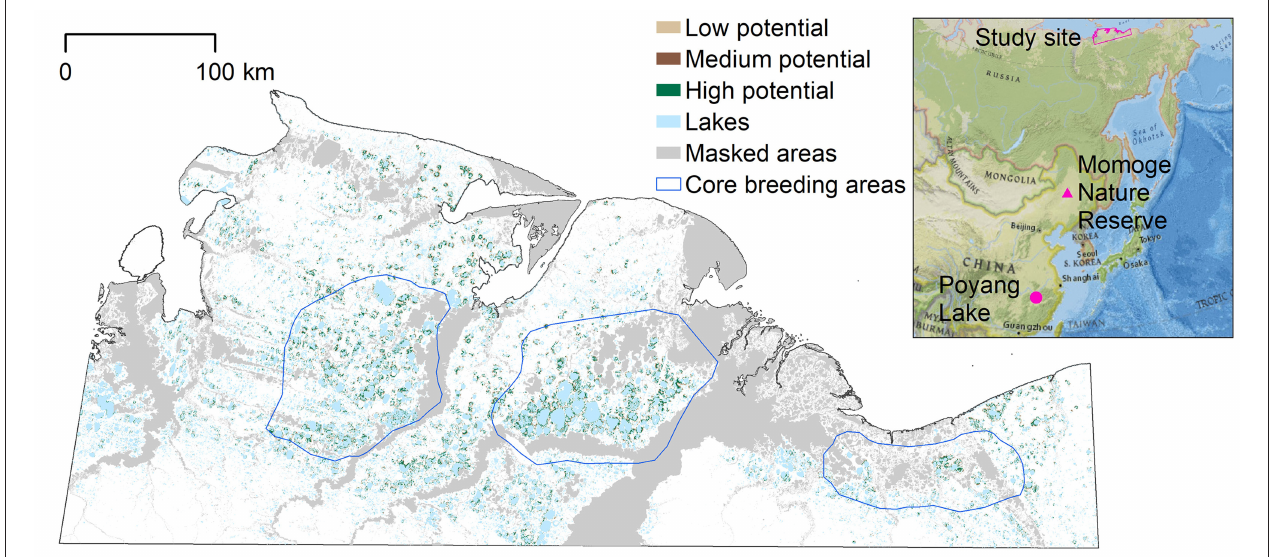
FIGURE 1 | Potential nesting habitat map for entire study area, based on the MaxEnt model. Masked areas along the coast, rivers, and their floodplains were not included in the model as Siberian crane nests have not been observed in these areas. The blue polygons represent the three core breeding areas identified in earlier studies; the westernmost around the Khroma River; the central, and most dense around the Indigirka River; and the eastern around the Alazeya River (Degtyarev and Labutin, 1991 ). The inset shows the location of the study area in northeastern Siberia, and locations of the migration stopover site (Momoge Nature Reserve) and winter feeding grounds (Poyang Lake) in China. Inset credit: National Geographic, Esri, Garmin, HERE, UNEP-WCMC, USGS, NASA, ESA, METI, NRCAN, GEBCO, NOAA, increment P